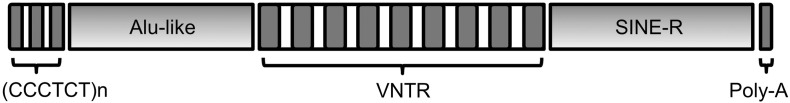
Schematic of a canonical SVA structure showing the five key domains, beginning with a 5′ repeat of the CCCTCT hexamer, followed by an Alu-like structure. The middle of the SVA contains a region of variable number tandem repeats (VNTRs), with older SVAs containing one, and younger SVAs containing two tandem repeat regions. A SINE-R region follows the VNTR, and a poly-A tail marks the 3′ end of the SVA.